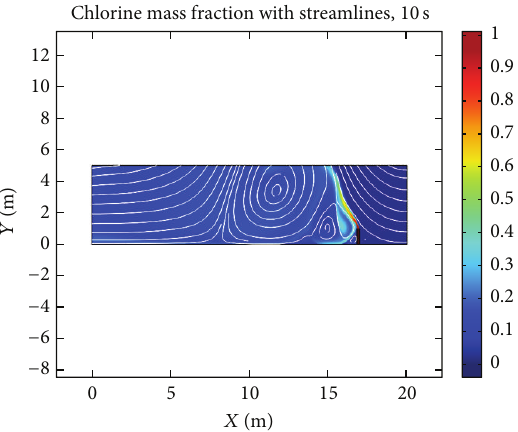
Figure 15: Chlorine mass fraction with streamlines after